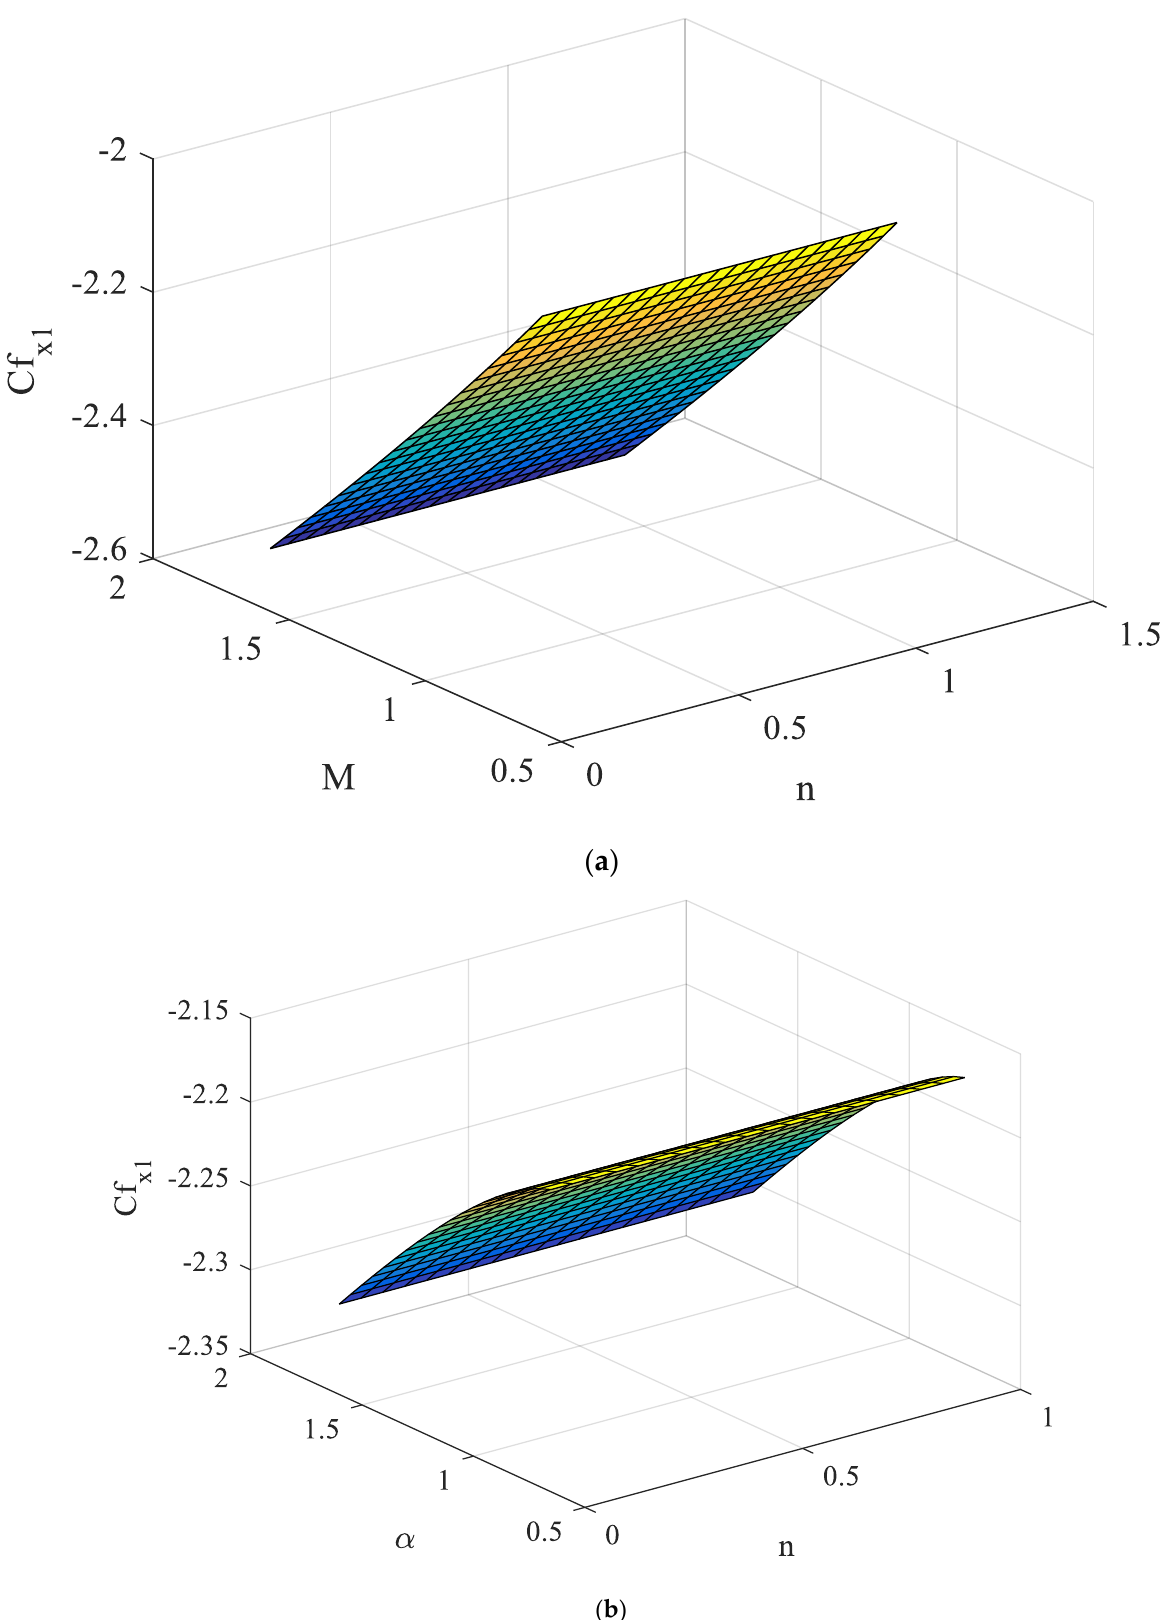
C f -direction for different values of 1 x